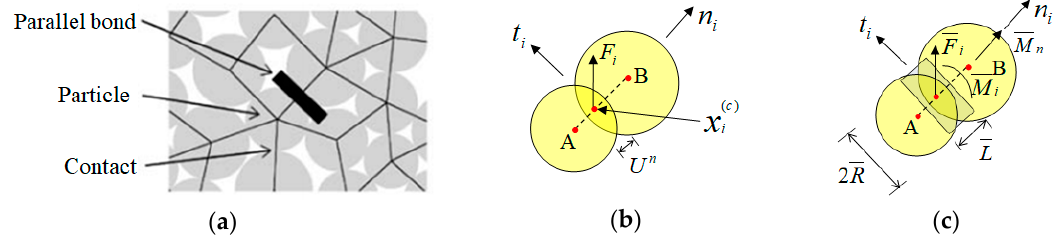
Figure 2. The contact model and parallel bond model: ( a ) intact material, ( b ) particle contact, and ( c ) parallel bond.